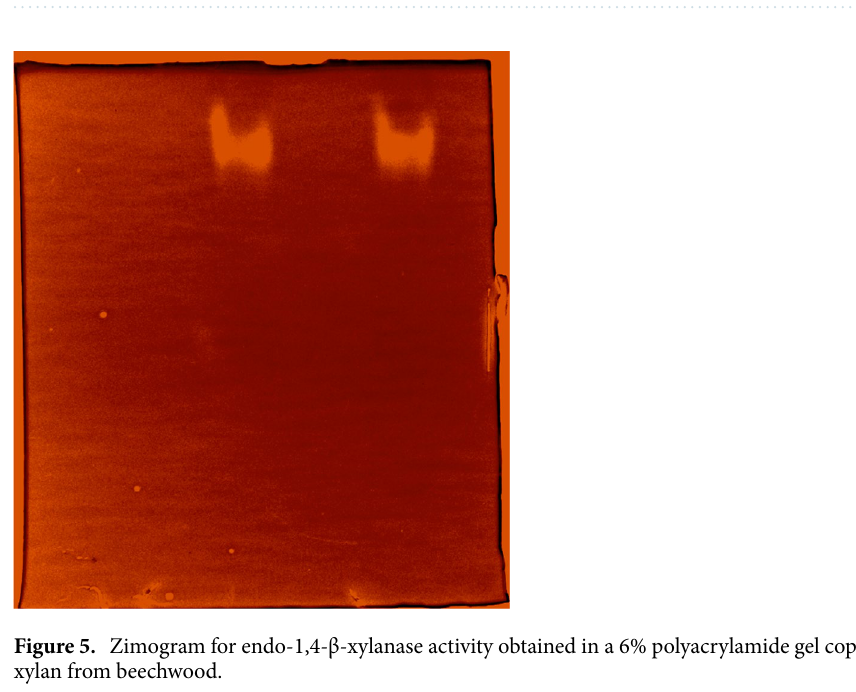
Figure 4. Chromatogram of purified XylR obtained by gel filtration using a Hiload 16/600 Superdex 200 column with a flow rate of 0.7 ml/minute. The internal image corresponds to the linear regression of the chromatography using the Protein Standard Mix 15 ± 600 kDa standard. Image built by GraphPad Prism software version 5.00. Image built by ImageLab 4.1 software. Notes: Protein Standard Mix 15 ± 600 kDa: Bovine thyroglobulin (670 kDa); bovine blood γ-globulin (150 kDa); chicken egg albumin fraction VI (44.3 kDa) and ribonuclease A (13.7 kDa).